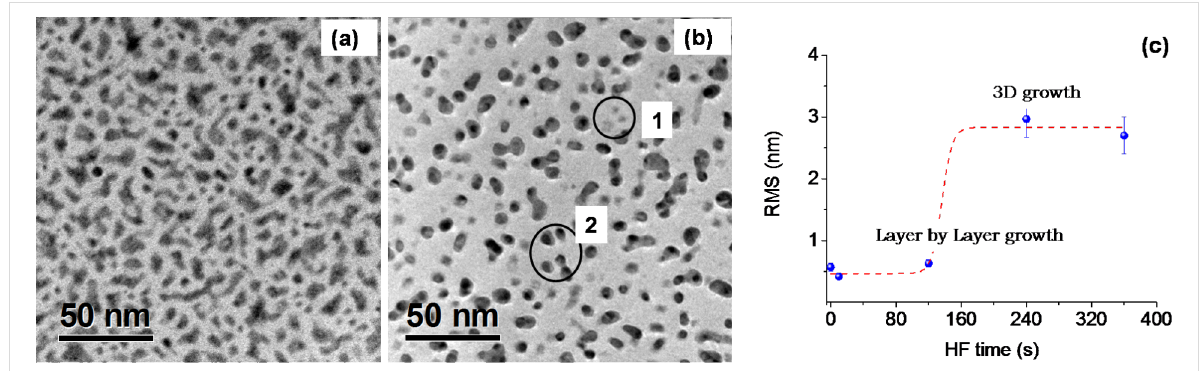
Figure 2: Gold electroless deposition on Si(100) after an DHF pretreatment of 10 s (a) and 240 s (b); root mean squared (RMS) for the correspond- ing Si substrates (c) measured with AFM.